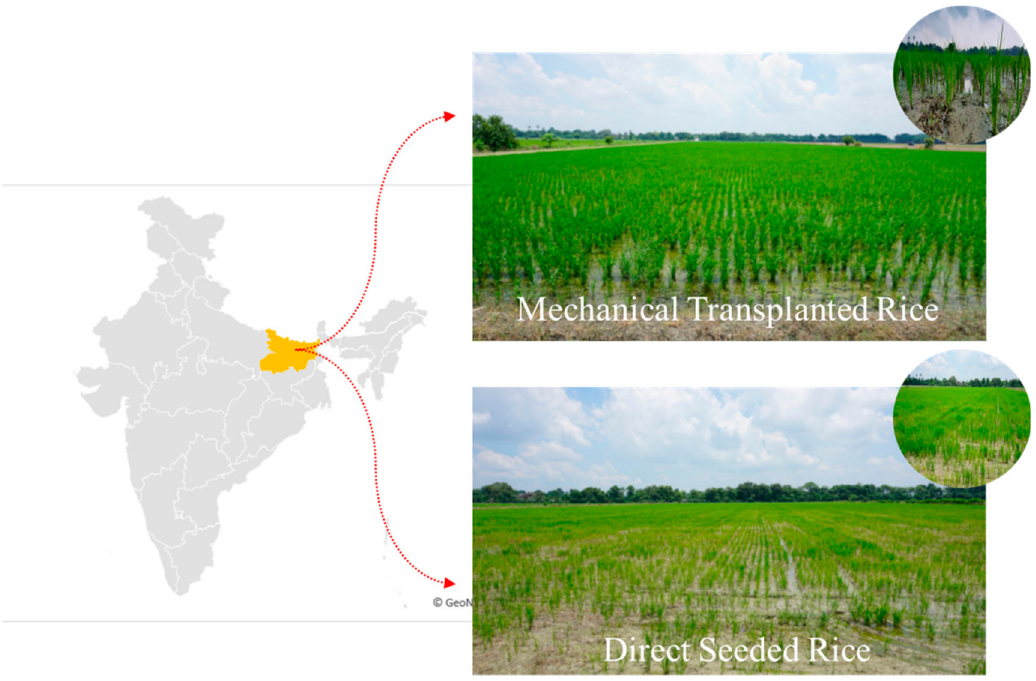
Figure 1. Experimental plot at the research station of the Borlaug Institute for South Asia (BISA- CIMMYT), Pusa, Samastipur (Bihar),